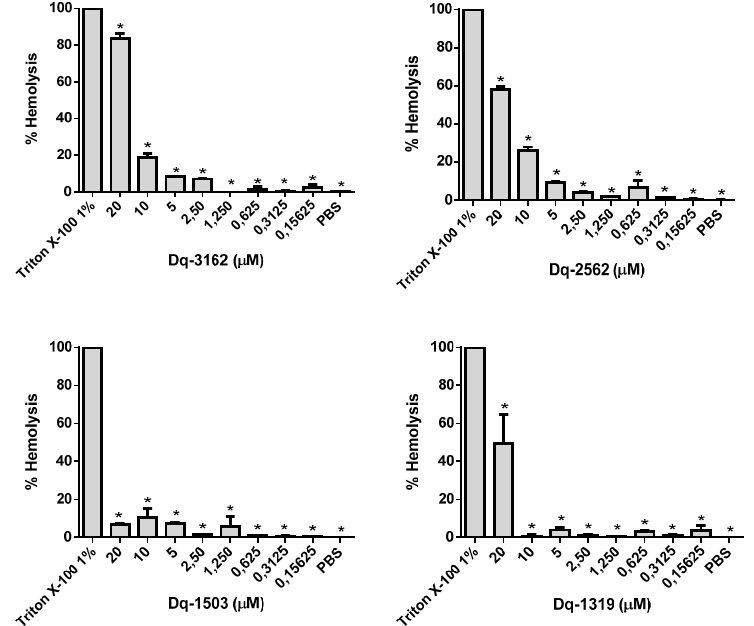
Figure 5. Percentage of hemolysis, in vitro, after exposure of human erythrocytes to synthetic pilosulin- (Dq-2562, Dq-1503, and Dq-1319) and ponericin-like (Dq-3162) peptides. Human red blood cells were treated with serial concentrations of these D. quadriceps antimicrobial peptides for 1 h, as described in materials and methods. ANOVA and Dunnett’s multiple comparisons test. * p < 0.05 (compared to 1% Triton X-100).